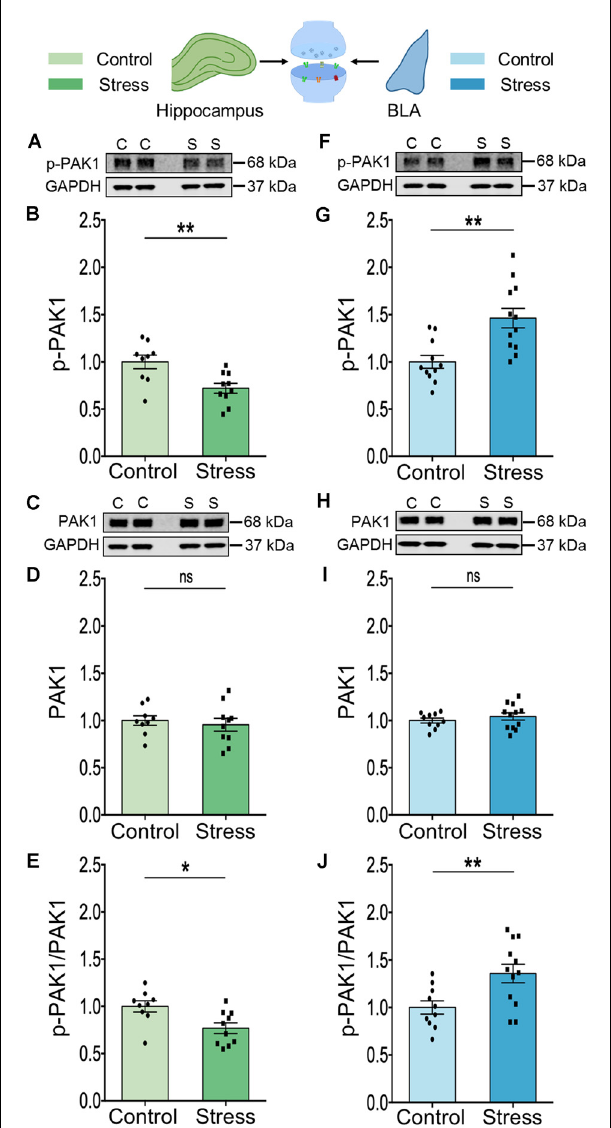
FIGURE 2 | Chronic stress mediates contrasting effect on the activity of the effector molecule PAK1 in the synaptoneurosome fraction isolated from the hippocampus and amygdala. (A,B) A significant decrease in the activity of PAK1 protein as represented by a decrease in its phosphorylation status has been observed in the hippocampus of the stressed rats compared to the controls as shown in the representative western blot (A) and the summary graph (B) . (C,D) No change has been observed in the abundance of the PAK1 protein in the hippocampus of stressed rats compared to controls as shown in the representative blot (C) and the summary graph (D) . (E) A significant decrease in the ratio of phospho-PAK1 to total-PAK1 protein has been observed in the hippocampus due to stress confirming a decrease in PAK1 activity. (F,G) A significant increase in the activity of PAK1 protein as represented by an increase in its phosphorylation status has been noticed in the amygdala of the stressed rats compared to the controls as shown in the representative western blot (F) and the summary data (G) . (H,I) No detectable difference in the abundance of the PAK1 protein has been viewed in the amygdala of stressed rats compared to controls as shown in the representative blot (H) and the summary graph (I) . (J) A significant increase